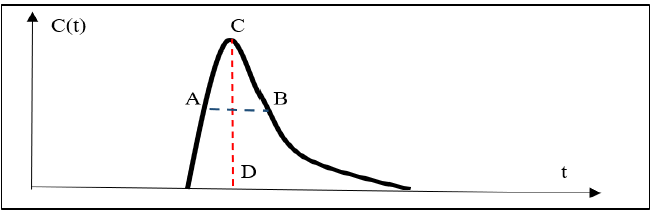
Figure 14: Independent "horizontal" and "vertical" measurements.